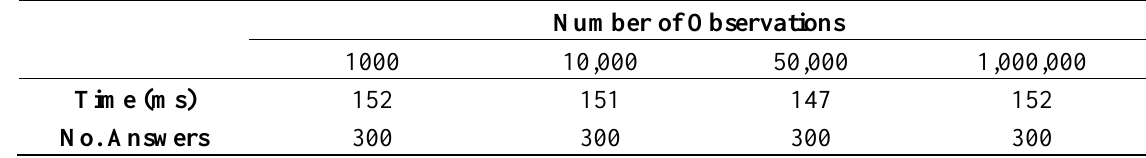
Table 3. Response times for SPARQL queries returning the same number of results from repositories of different